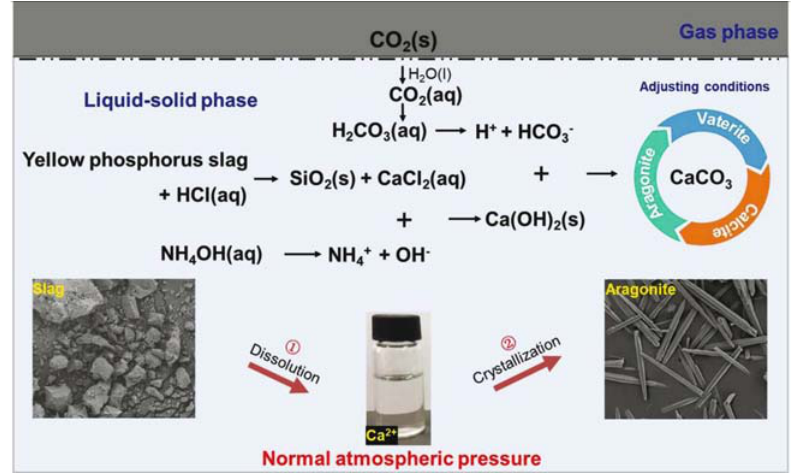
Figure 7: Proposed schematic diagram of yellow phosphorus slag carbonation for aragonite